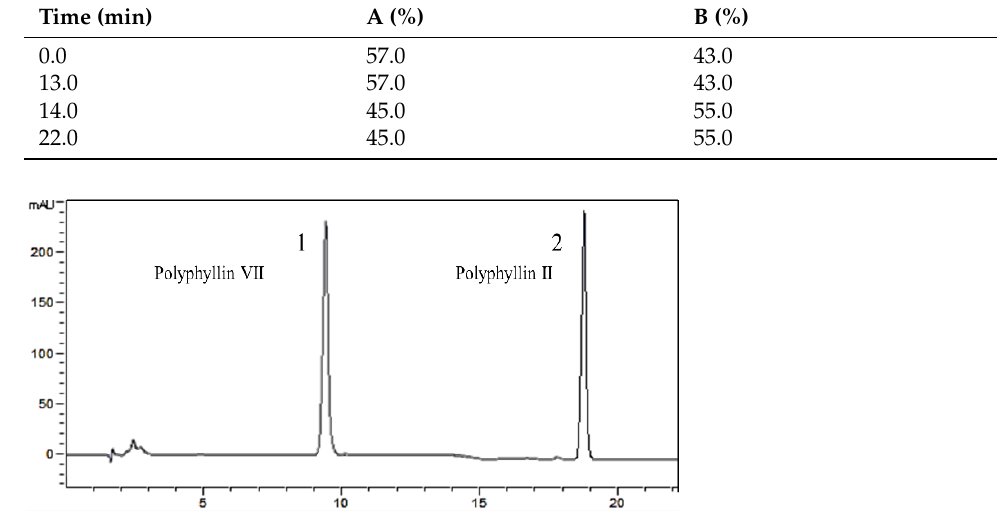
Figure 3. HPLC chromatograms of standards: polyphyllin VII (1) and polyphyllin II (2). Table 2. The mobile phase consisted of A (water) and B (acetonitrile) using the gradient elution method.